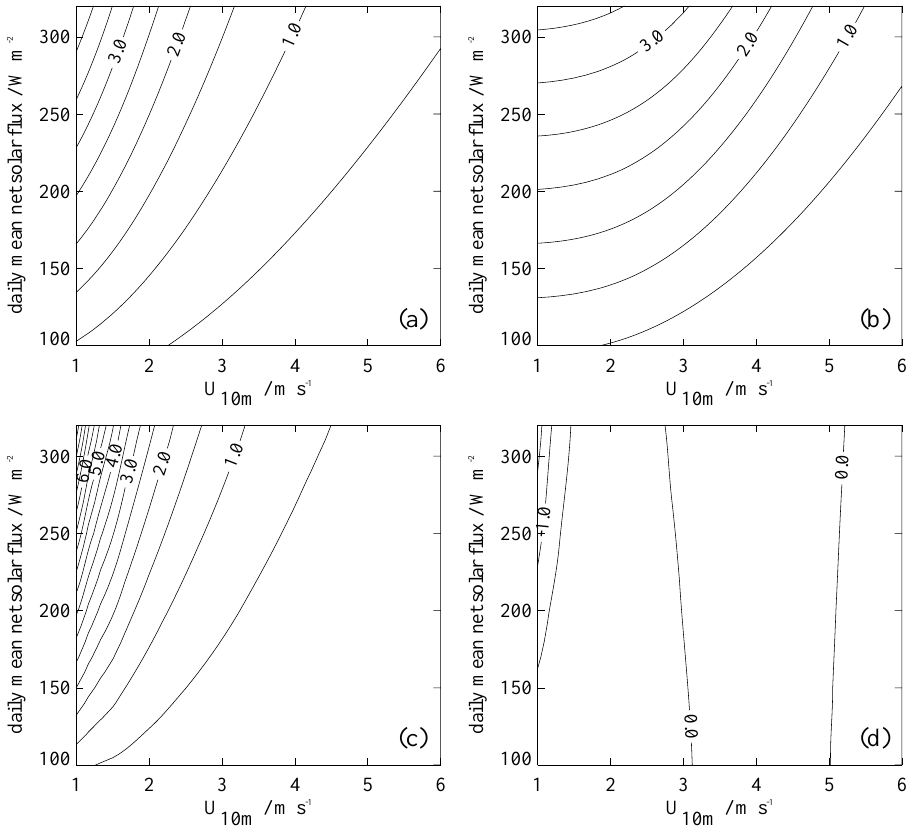
Fig. 9. Diurnal warming (K) at 14:00LT as a function of daily mean net solar heat flux and wind speed at 10m ( U 10m ) , calculated by three models. The non-solar heat flux to the surface was set to − 100Wm − 2 . (a) The statistical model, (b) the model developed by Zeng and Beljaars (2005), (c) the Profiles of Surface Heating (POSH) model (Gentemann et al., 2009), and (d) the change in the warming predicted by the POSH model when interaction with the atmosphere is included (the values range from − 1.5K to